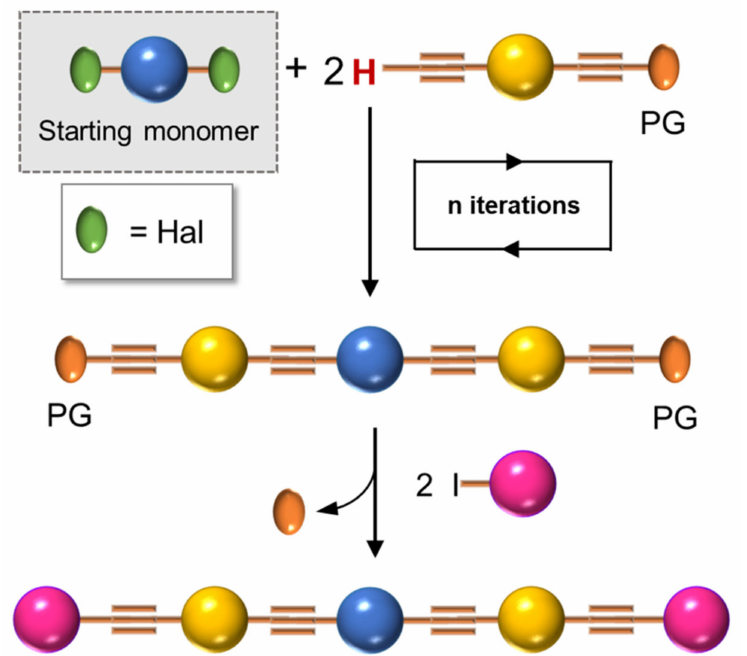
Scheme 6. Schematic representation for preparation of symmetrical OPEs longer than three repeti- tive